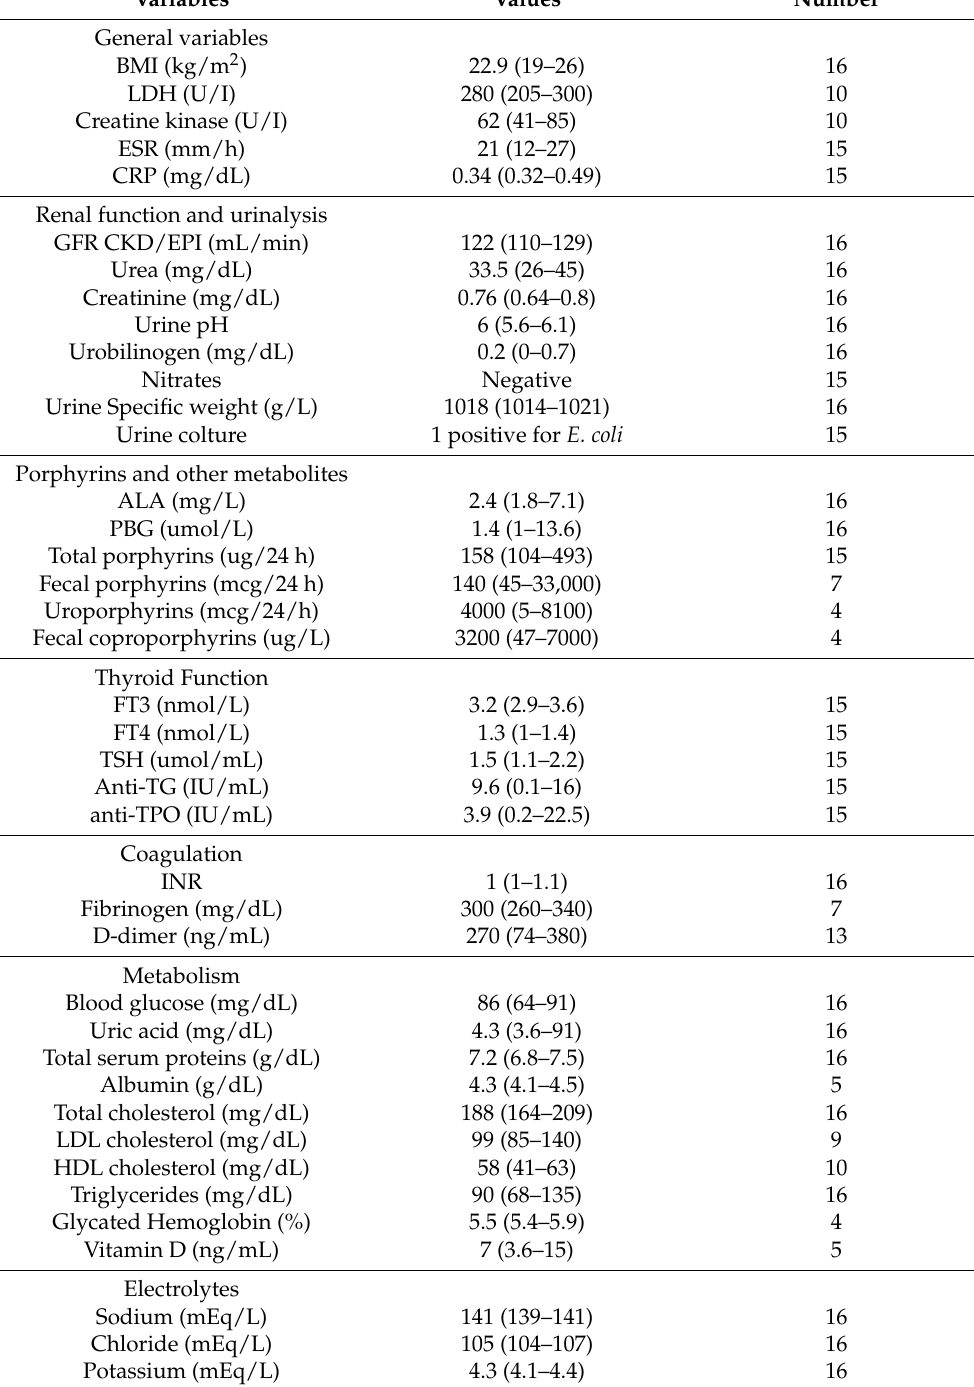
Table 1. Laboratory characteristics of patients affected by